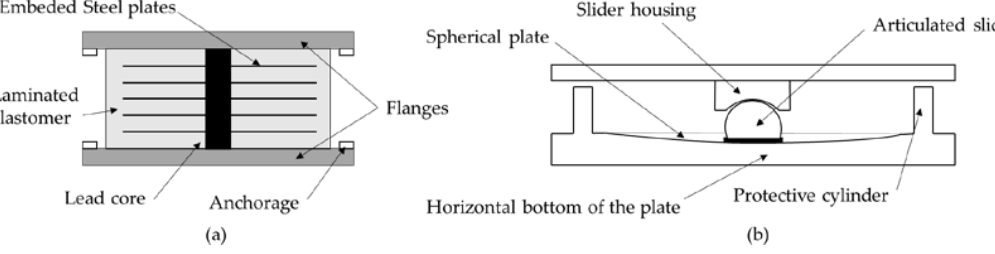
Figure 5. Isolation bearing schematics ( a ) elastomer (rubber)-based; ( b ) friction (sliding)-based.